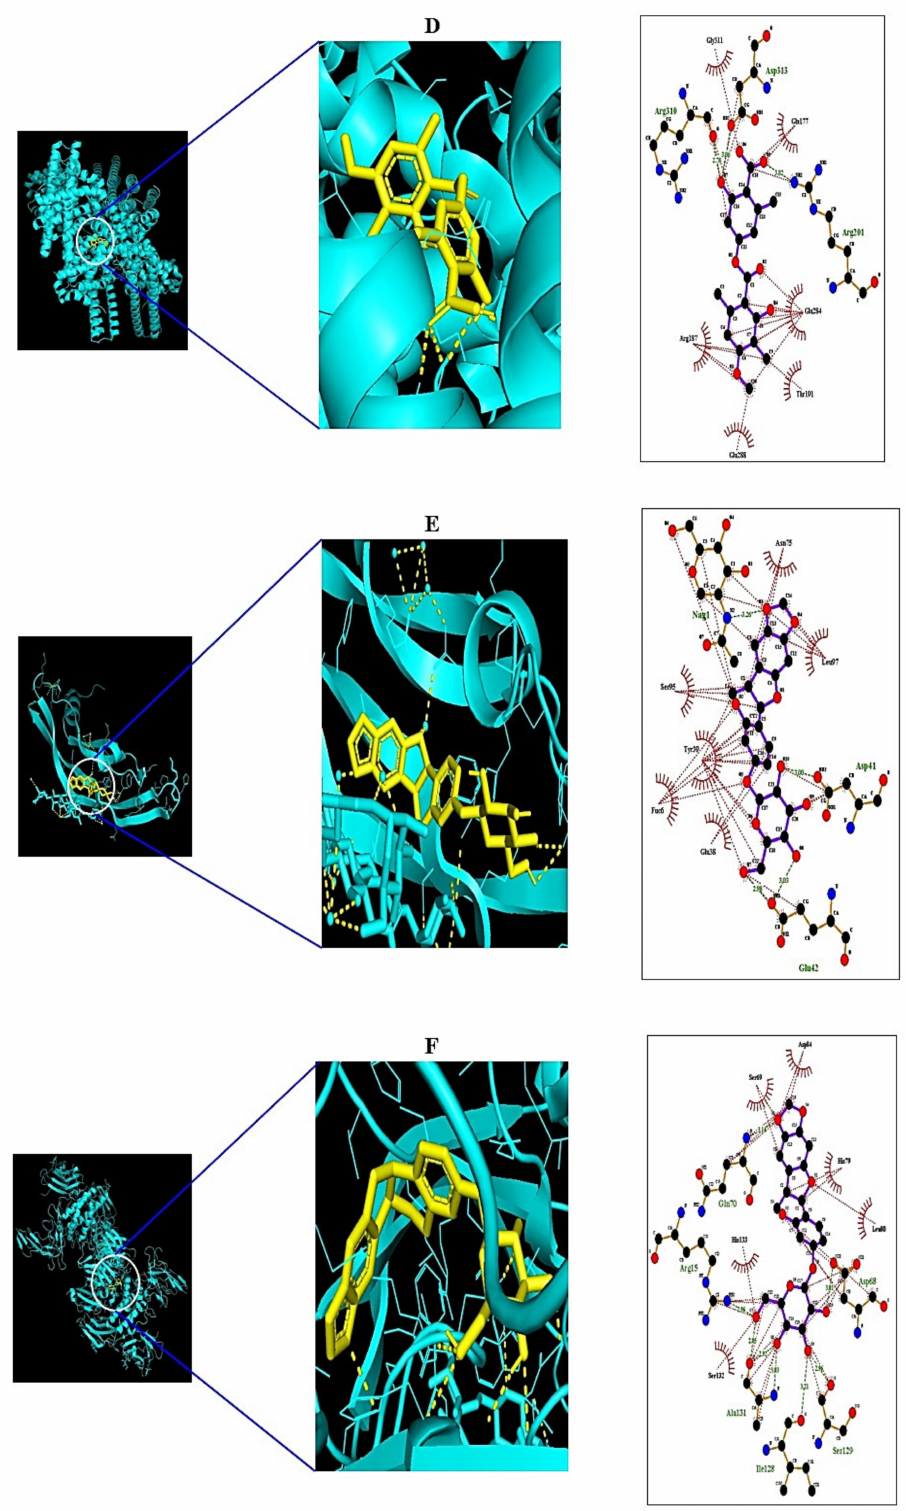
Figure 8. Molecular docking interaction between best docked compounds from PGCAM and target proteins. ( A ) Paeonol on 1NFI ( B ) Frutinone A on 1SVC ( C ) Nepetin on 4CNI ( D ) Ramalic acid on 5JSB ( E ) Trifolirhizin on 4KZN ( F ) Trifolirhizin on 2ERJ. Docking simulation of the affinity between R1-R2 and RELA protein in the “ Homo sapiens ” setting was analyzed. Based on the docking score, the order of priority of